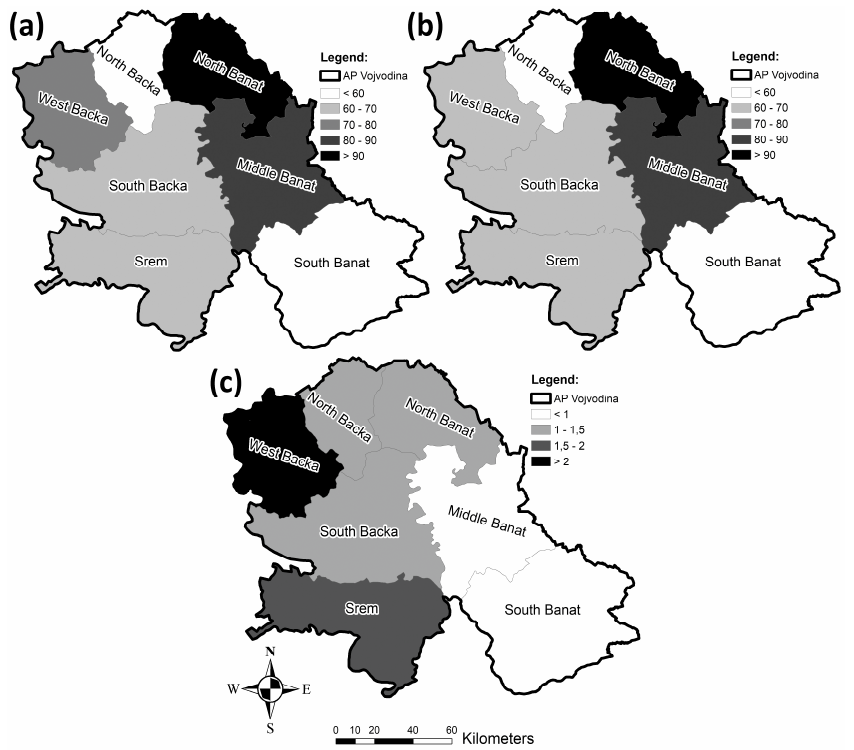
Figure 15. Cardiovascular diseases mortality rates per 100,000 population in the researched area from 2010 to 2020: ( a ) acute coronary syndrome, ( b ) myocardial infarction, and ( c ) unstable angina